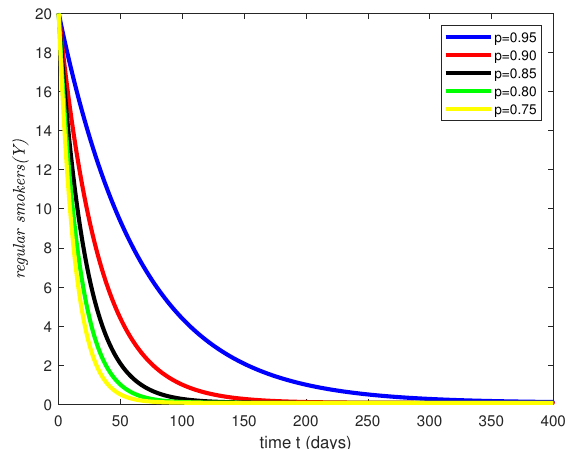
Figure 4. Adaptive nature of the approximated result for the regular smokers Y ( t ) class of the proposed model at different arbitrary fractional